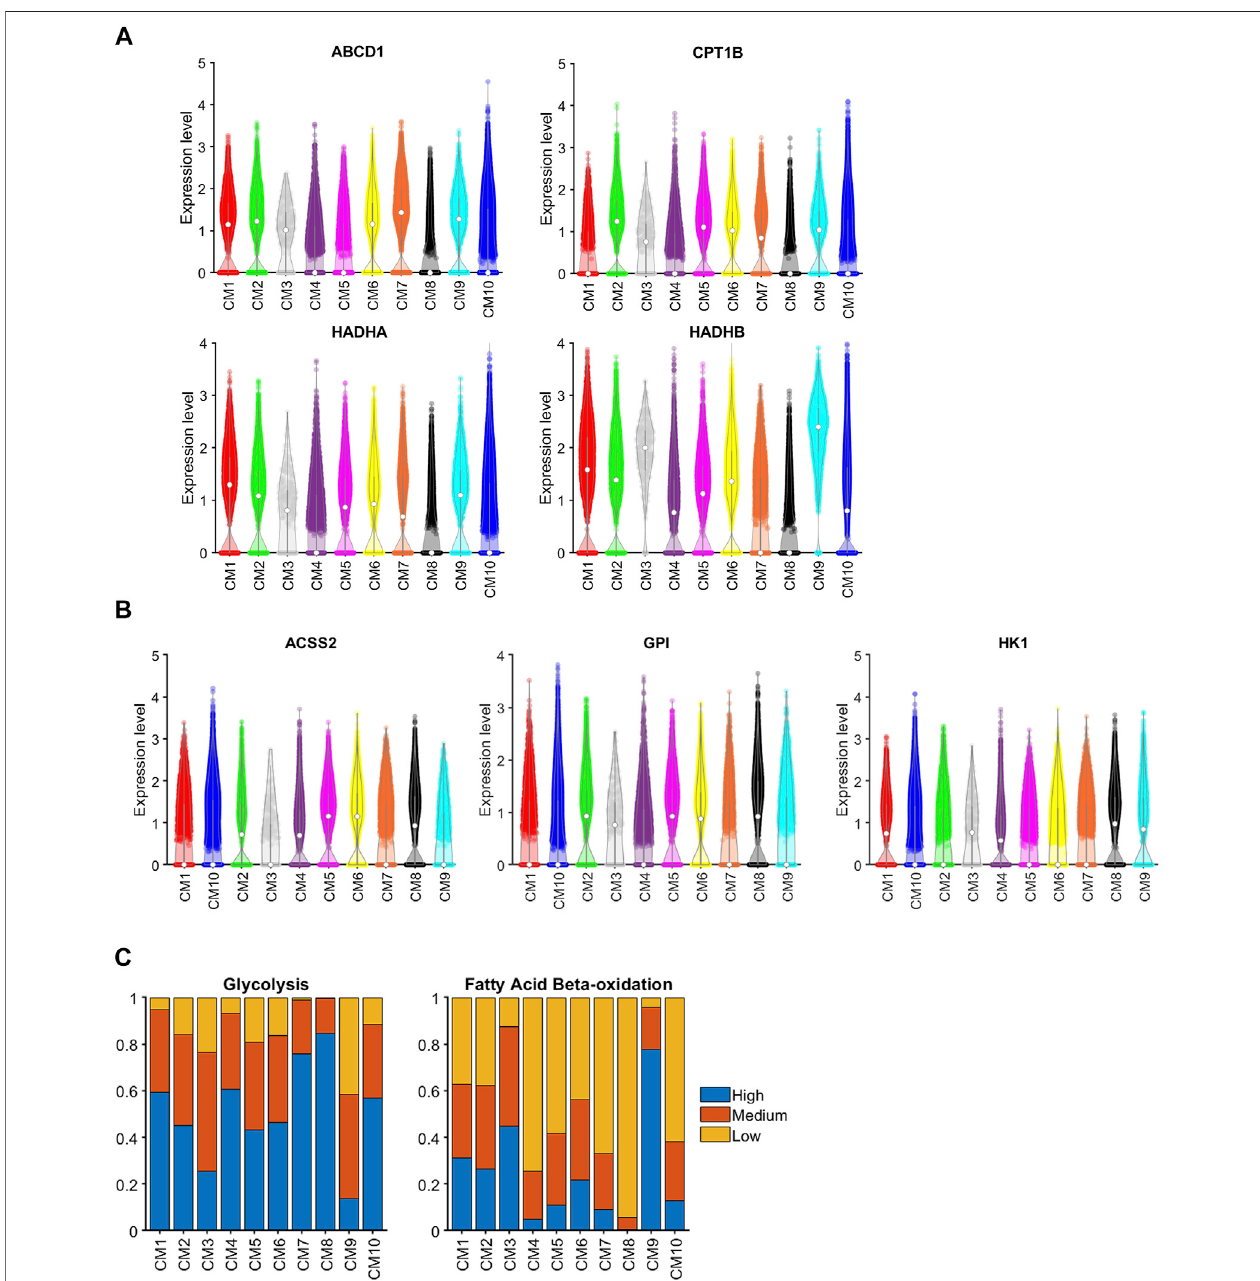
FIGURE4| Genesassociatedwithboth glycolysisand β FAOX wereupregulatedinCM1 and CM2.The abundance ofRNAtranscripts forgenesthatcontribute to (A) glycolysis (ABCD1, CPT1B, HADHA, and HADHB) and (B) β FAOX (ACSS2, GPI, and HK1) was measured in cardiomyocytes from each cluster and displayed in a violinplot. Theexpression wasnormalizedaccording totheSeuratpipeline: theexpression matrixwasscaled bytheScaleDatafunctionwithvars.to.regress settonUMI and nGenes; then, the scaled expression was log-normalized. (C) Sparse analysis was conducted for the expression of glycolysis and β FAOX genes, and the proportion of cardiomyocytes with high, medium, or low levels of expression was calculated for each cluster.